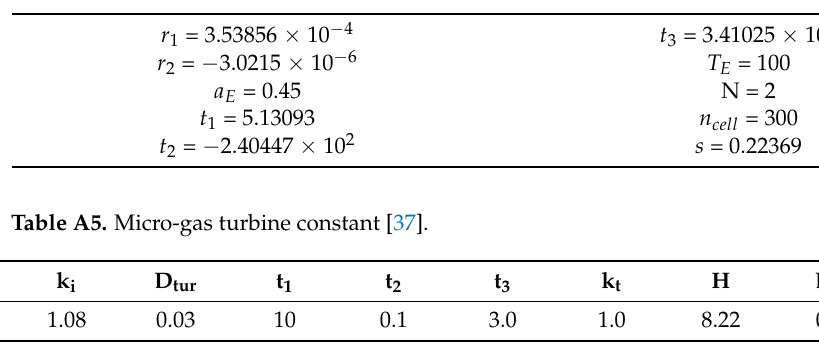
Table A4. Alkaline water electrolyzer constants [36].